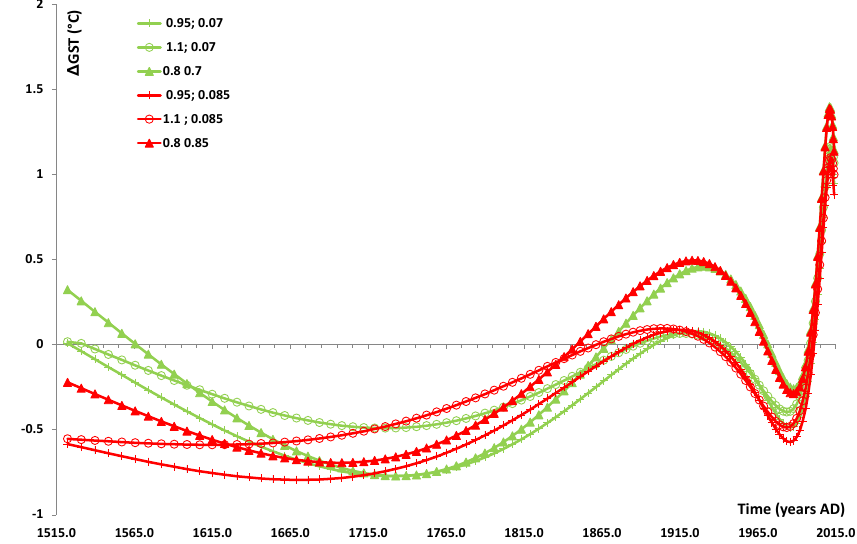
Figure 9. Example of different GST histories with different α values with the extreme of heat flow values known for the region. Legend: green lines are obtained with a heat flow of 70mWm − 2 while red lines are obtained with 85mWm − 2 . The different symbols indicate different α values (0.95: solid line; 1.1: empty dots; 0.8: triangles).